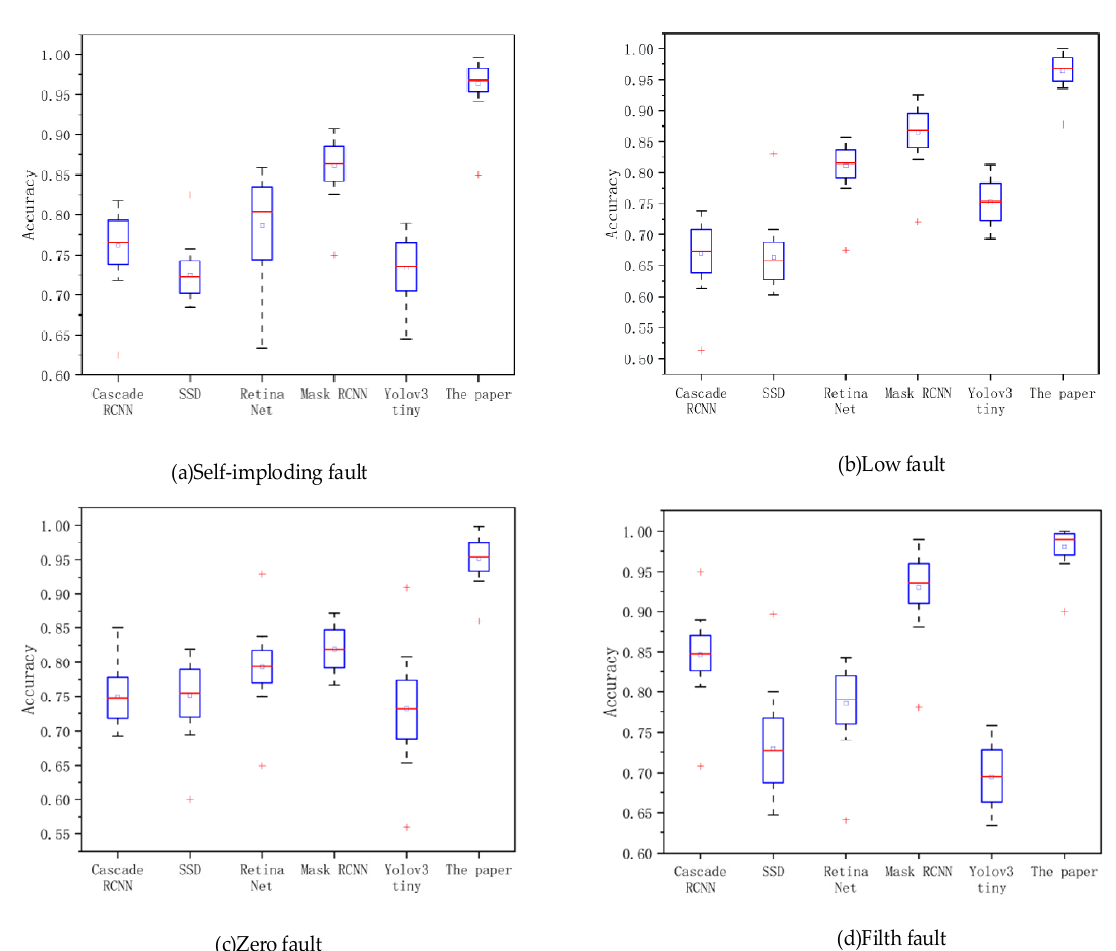
Figure 13. Boxplot of recognition accuracy of different methods. The red “+” represents outliers in the detection results. Each box has two black “ − ”, one above and the other below, representing the upper and lower limits of the box, respectively. The blue rectangle has upper and lower lines, which represent the upper and lower quartiles, respectively. There is also a short red line in each rectangle, which represents the median in the results. In addition, there is a small blue square in the center of each bin, which represents the mean across the set of results.